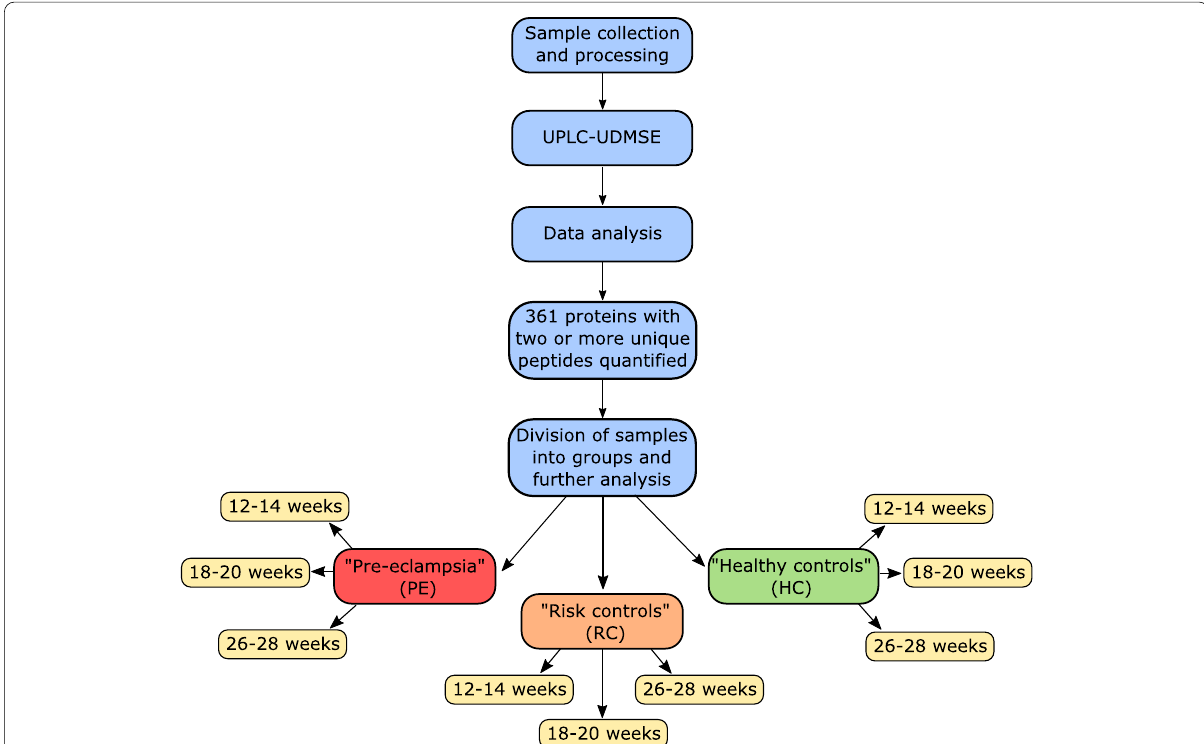
Fig. 1 Flowchart showing the study design and subsequent division of samples into groups for further analysis. Samples were collected and processed, after which ultra performance liquid chromatography-ultra definition mass spectrometry (UPLC-UDMS E ) was performed. The raw data was analyzed and we subsequently identified 361 proteins with two or more unique peptides. The samples were divided into groups, after which further statistical analyses were performed. First, the samples were divided into three groups: women who developed PE (“Pre-eclampsia”), women with clinical risk factors for PE who did not develop PE and were classified as at-risk controls (“Risk controls”), and controls without known risk factors for PE (“Healthy controls”). Within each group, the samples were also analyzed according to time point when the samples were